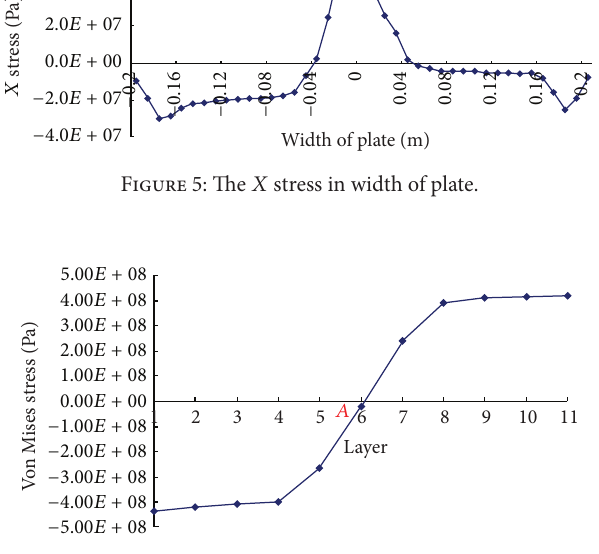
Figure 6: The Von Mises stress in the cross